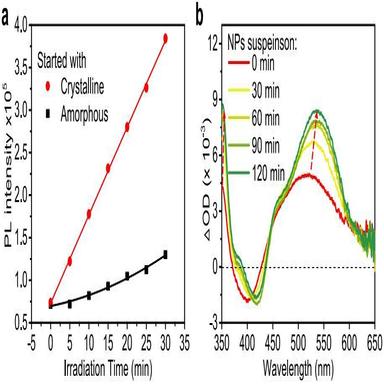
Time evolution of singlet oxygen-dependent fluorescence intensity (at 529 nm, λex = 504 nm) of SOSG in the presence of ETTDA NPs suspension started with crystalline and amorphous phase (a) and fs-TA spectra of ETTDA NPs suspension at 1 ns recorded at a different time (b).